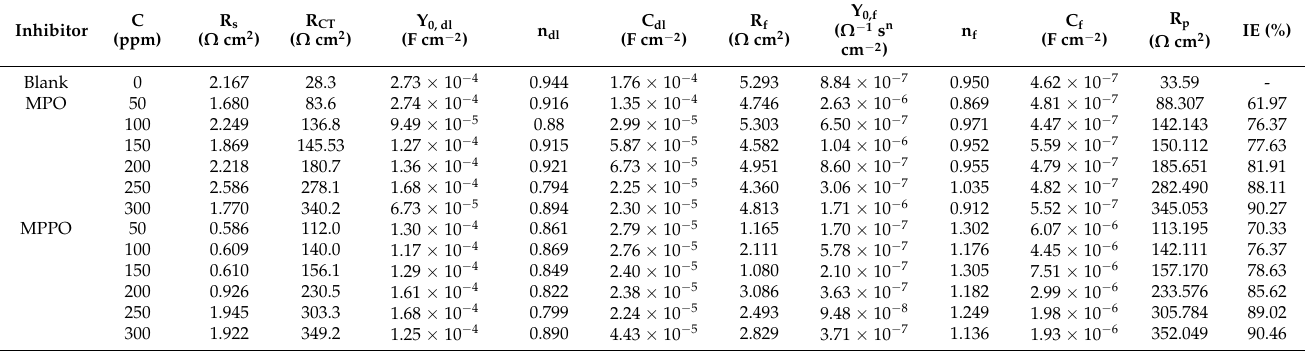
Table 4. Electrochemical parameters obtained from EIS data for N80 steel in 1M HCl solution containing different concentrations of MPO and